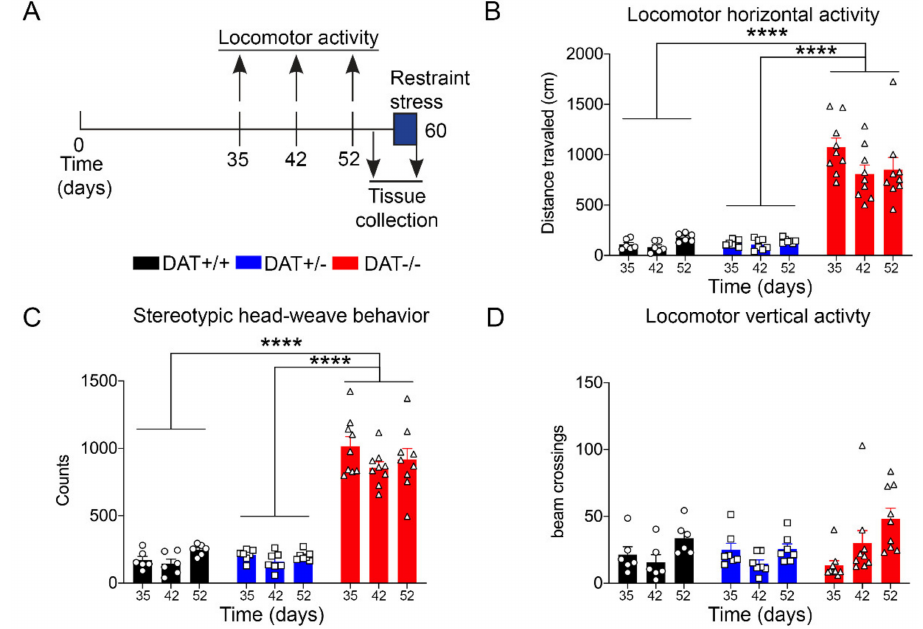
Figure 1. Locomotor activity in Wild-type control (Dopamine Transporter (DAT) +/+ ), Heterozygous (DAT +/ -), and Homozygous (DAT - / -) rats. ( A ) Schematic diagram for locomotor activity, restraint stress and tissue collection. Genetic ablation of DAT leads to elevation in ( B ) Horizontal activity, and ( C ) Stereotypic behavior, without alterations in ( D ) Vertical activity, on postnatal day (PND) 35, 42, and 52, ( n = 7–8 per group). Data were expressed as mean ± SEM in the 0–10 min period. **** p <